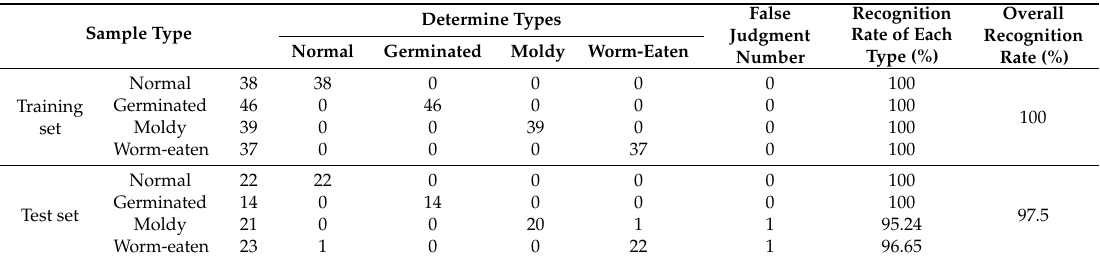
Table 2. Modeling results of the radial basis function support vector machine (RBF-SVM) wheat classification fusion model.